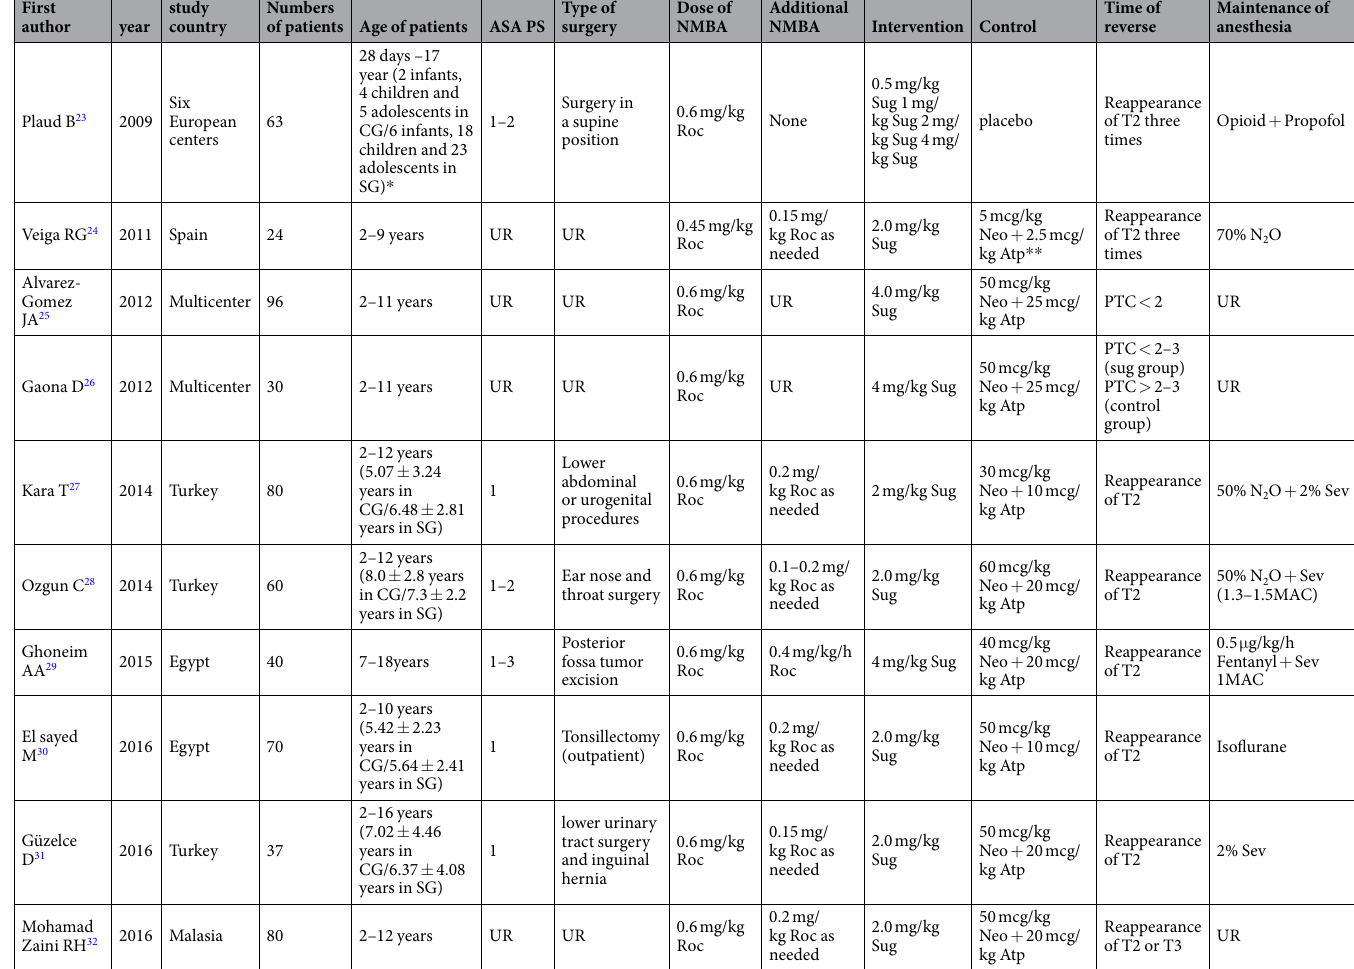
Table 1. Characteristics of included studies. ASA PS: American Society of Anesthesiologists’ physical status. NMBA: neuromuscular blockade agents. UR: unreported. Roc: Rocuronium. Sug: sugammadex.